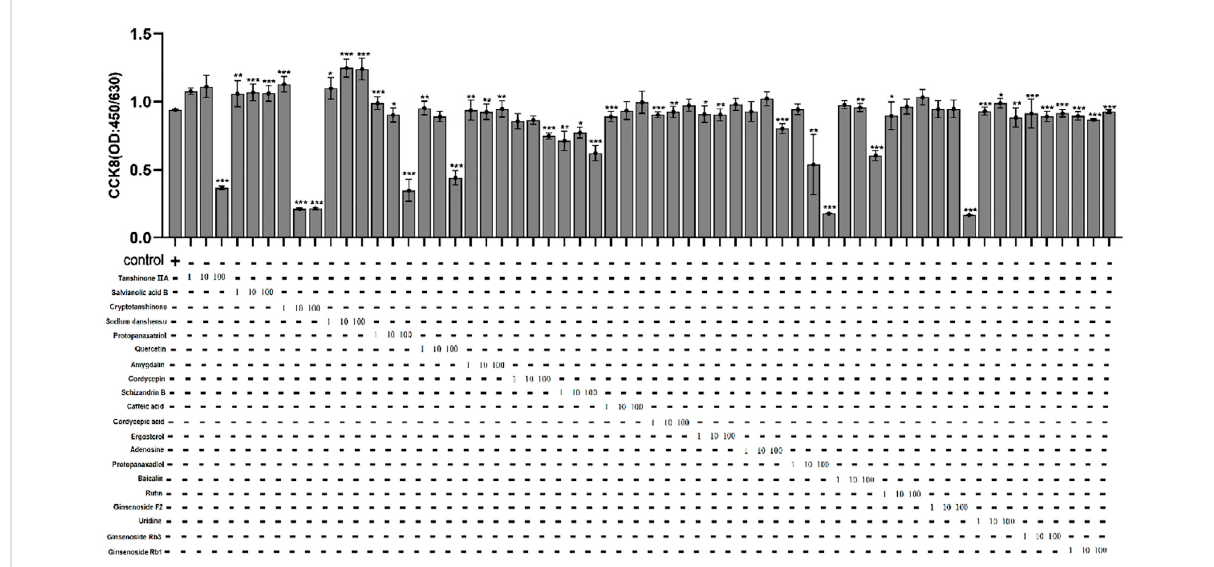
FIGURE 7 The cytotoxicity of 20 main active compounds of FZHY on HepG2.2.15 cells. Each group vs. control group, * p < 0.05, ** p < 0.01, *** p < 0.001.